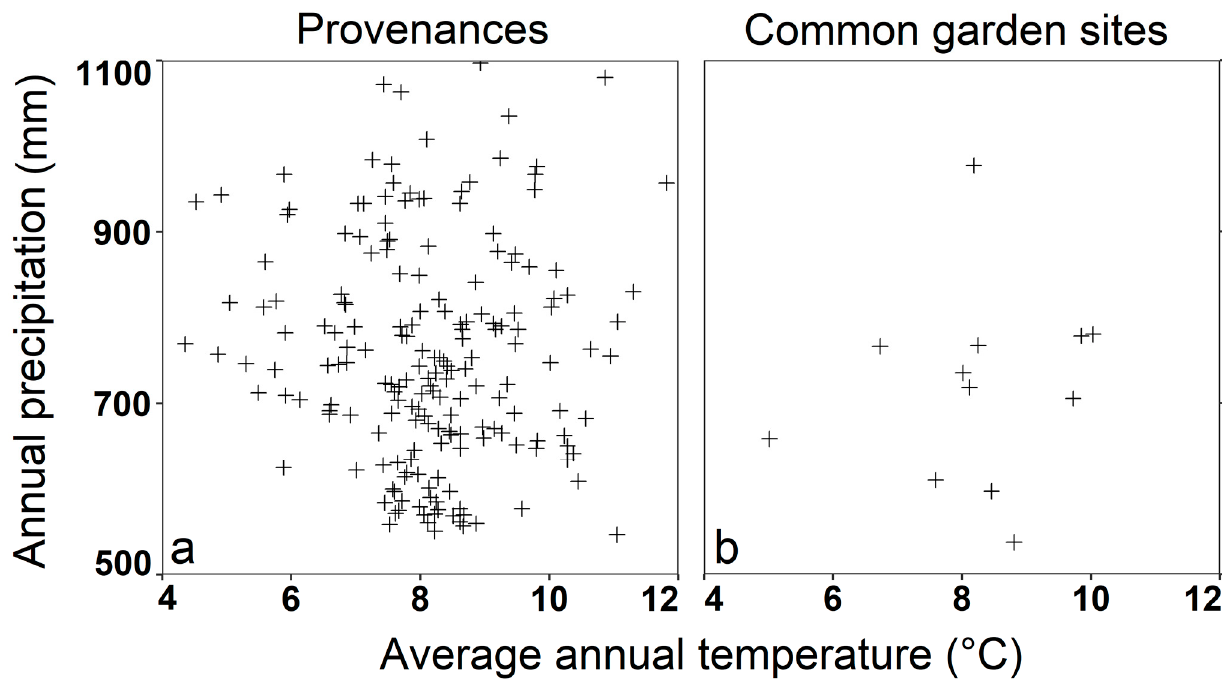
Figure 2. Average annual precipitation and average annual temperature at the sites of provenance origin (1961–1990, ( a )) and at the common garden sites (1995–2002/1998–2005, ( b )).